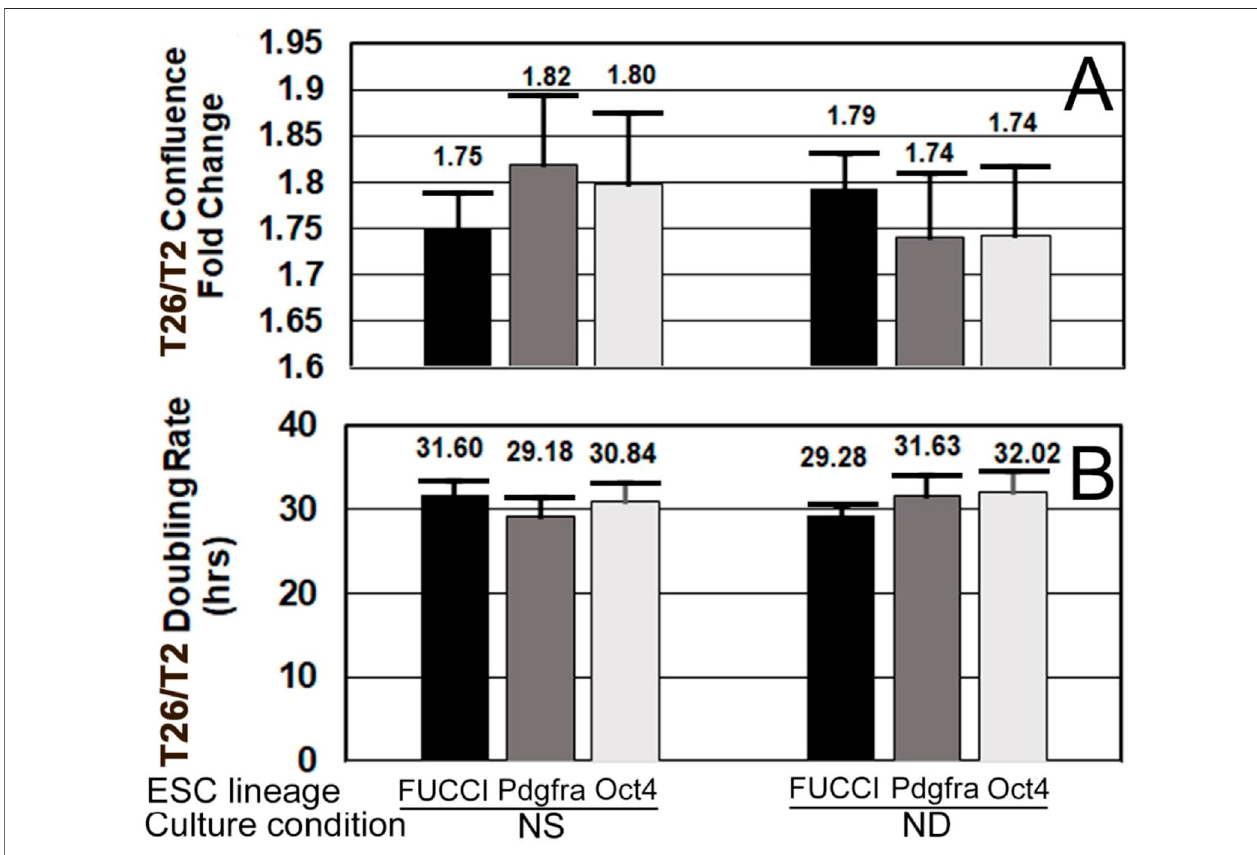
FIGURE9| FUCCIandtwootherESClineshavesimilargrowthratesanddoublingtimeswhenculturedinnormalstemness(NS,LIF+)ornormaldifferentiation(ND, LIF-)foroneday. (A) FUCCI,Pdgfra,andOct4ESCwereculturedandassayedasshownin Figure4 ,exceptcon fl uenceincreaseanddoublingratewerebothmeasured in the fi rst 24 h when rate of increase was highest and not as affected by contact inhibition. Con fl uence fold change from timepoints T2 to end of day 1 is shown. (B) Duringtheculture ofthesamethree ESClinesfrom T2 – T26,changeincon fl uencewasusedtocomputethedoublingrate.Sixindependentbiologicalexperiments forFUCCINS(N (cid:1) 26)andND(N (cid:1) 17).FourindependentexperimentsforPdgfraNSandND(N (cid:1) 8forboth).FiveindependentexperimentsforOct4ESCforNSandND (N (cid:1) 10 for both). There were no signi fi cant differences ( p > 0.05) between cell types for NS or ND.